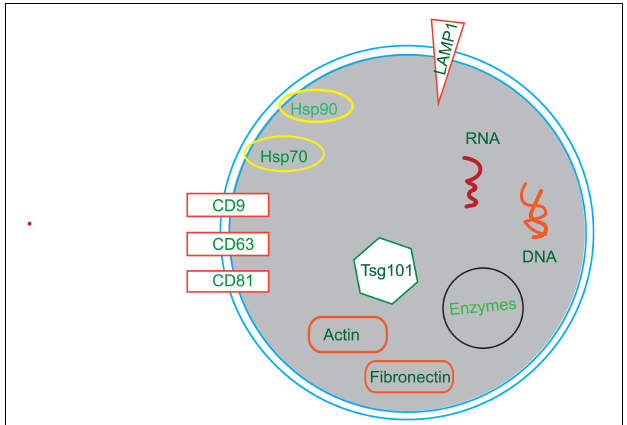
FIGURE 2 | The compositions of exosomes. Exosomes are composed of in a variety of bioactive substances, mainly proteins, nucleotides and lipids. Proteins include tetraspanins (e.g., CD9, CD63, and CD81), heat shock proteins (e.g., Hsp70, Hsp90), cytoskeletal proteins (e.g., Actin, Fibronectin), viral proteins (e.g., Tsg101) and enzymes. Nucleotides include RNA and DNA.